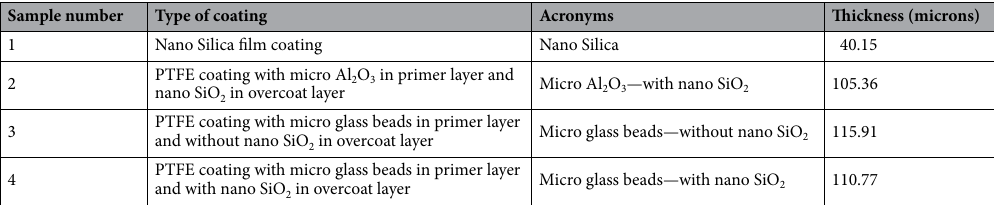
Table 1. Specifications of the fabricated coatings with their average